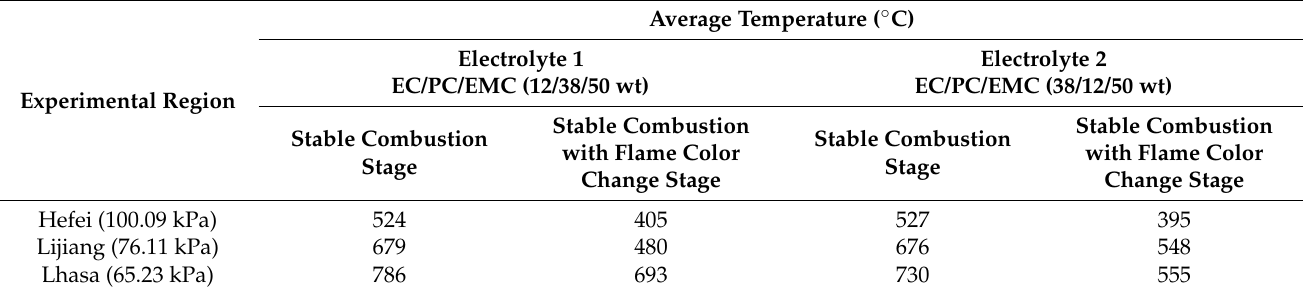
Table 5. The list of average HRR in Lijiang (76.11 kPa) and Lhasa (65.23 kPa) as Q values during the z *